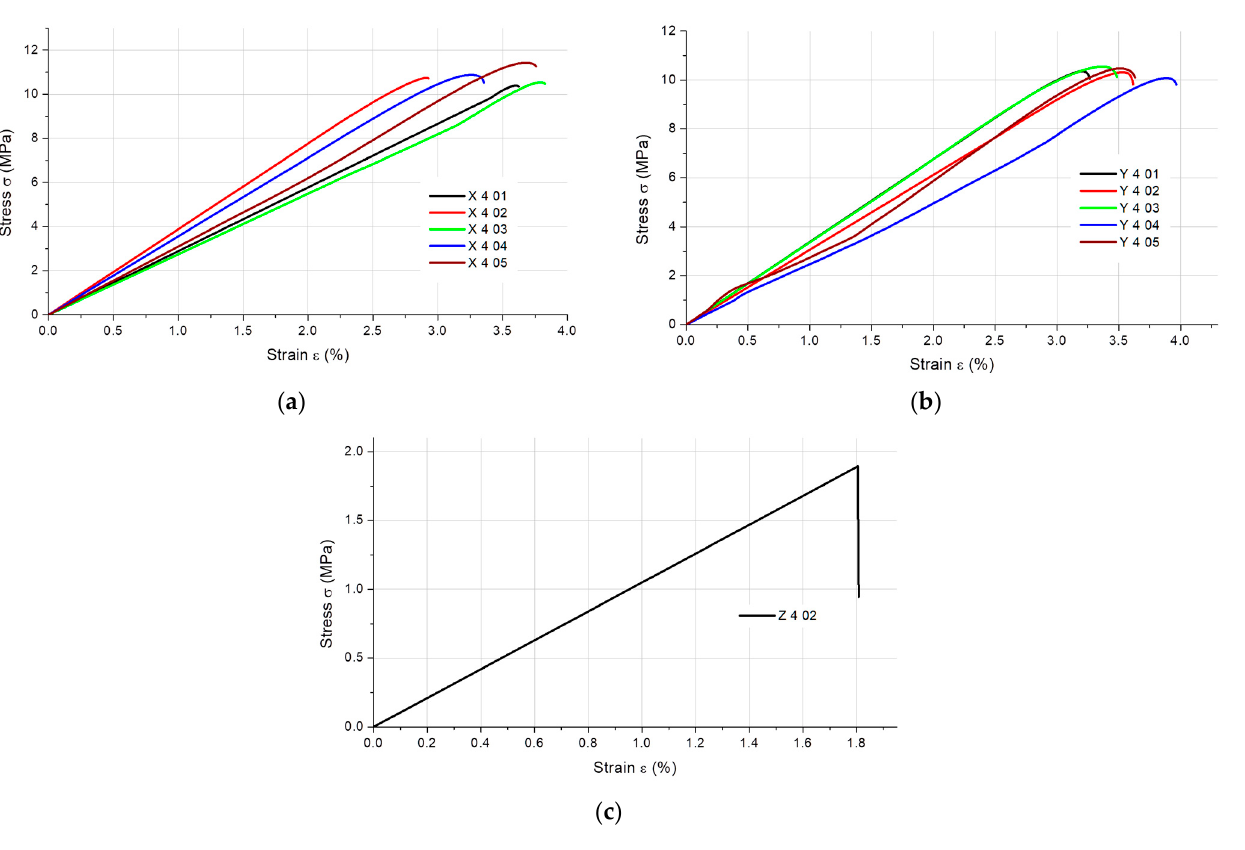
Figure 4. Stress–strain curves for the 1.8 mm thick specimens composed of PLA + bronze printed in